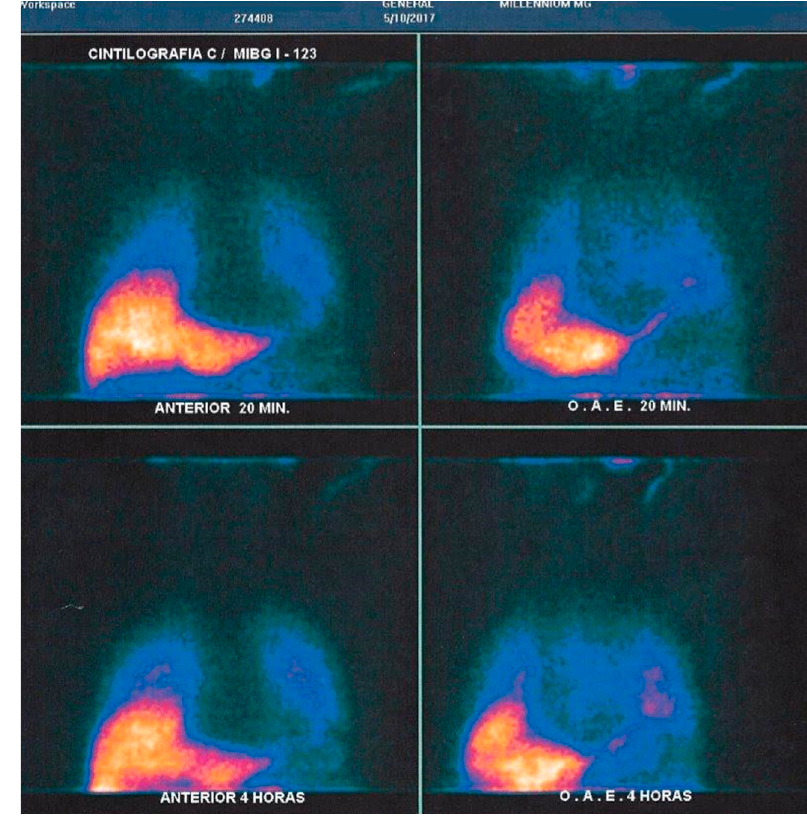
Figure 2. MIBG-123I Scintigraphy showing reduced radiotracer uptake in cardiac chambers, indicating significant sympathetic